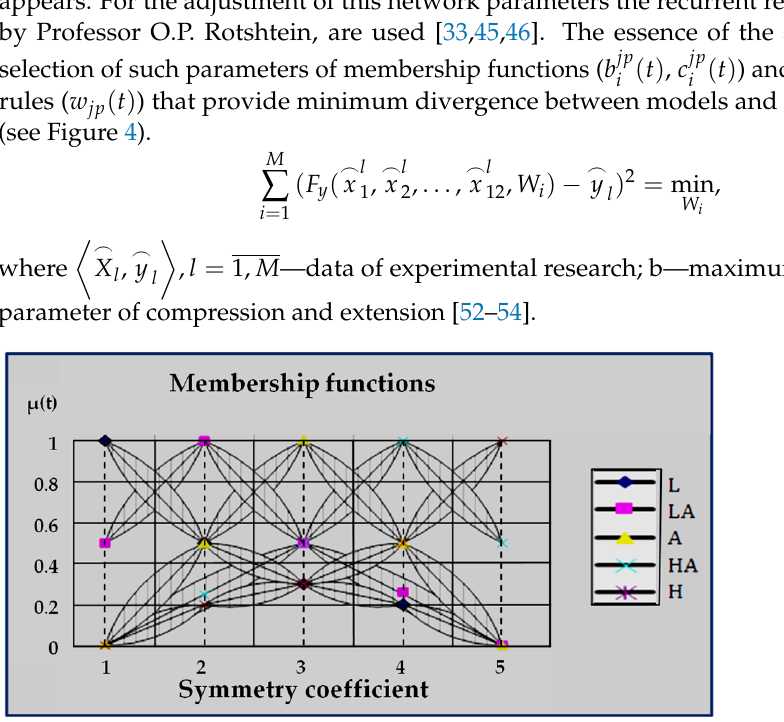
Figure 4. Membership functions of fuzzy terms after the tuning procedure